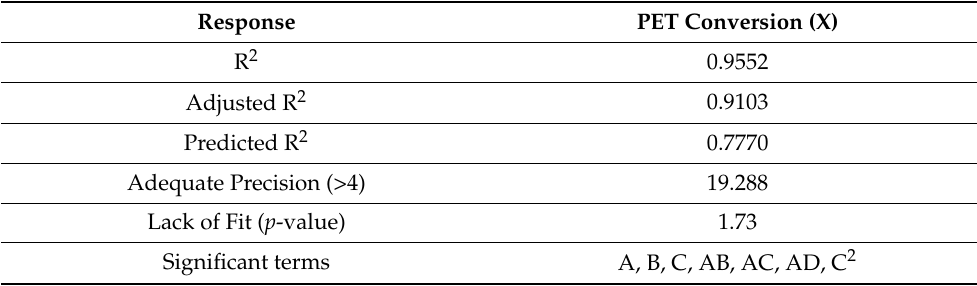
Table 2. Statistics parameters for the regression model (Equation